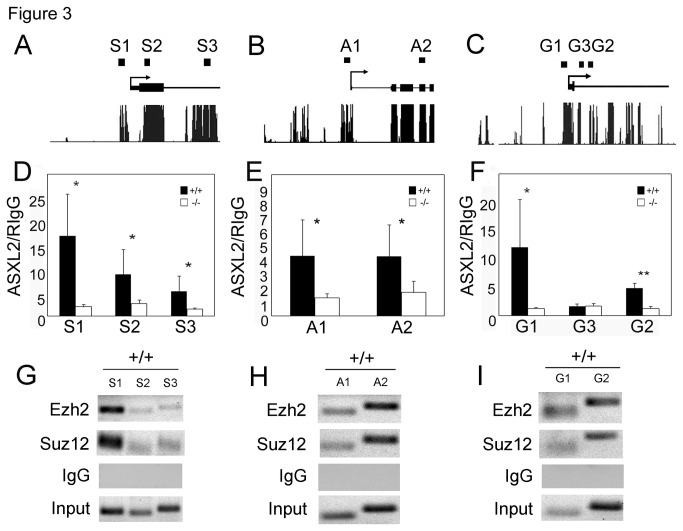
ASXL2 and PRC2 core components co-localize at select target loci.(A–C) Alignment of mouse, rat and human genomic sequences from -2kb to +2kb of Sfrp2 (A), Acta1 (B), and Grk5 (C). The peaks correspond to regions of sequence conservation. For each gene, 2-3 highly conserved regions (black bars on top of the graphs, designated S1-3, A1-2 and G1-3, respectively) were selected for ChIP analysis. (D–F) ChIP-qPCR assays of ASXL2 enrichment near Sfrp2 (D), Acta1 (E) and Grk5 (F) TSSs in 1-month-old wild-type and Asxl2
-/- hearts. Each column represents the mean value of data from three independent samples. Mock ChIPs were performed with rabbit IgG. (G–I) ChIP-PCR assays of EZH2 and SUZ12 enrichment near Sfrp2 (G), Acta1 (H) and Grk5 (I) TSSs in 1-month-old wild-type mouse hearts. Input: PCR assays of 1:100 diluted total input chromatin. *p<0.05; **p<0.01; Error bar: standard deviation.